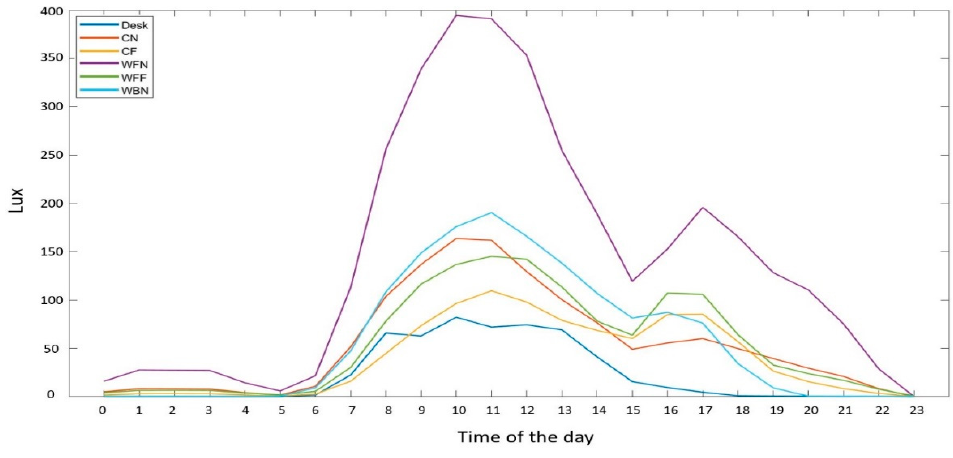
Figure 10. Time series of light sensors in various